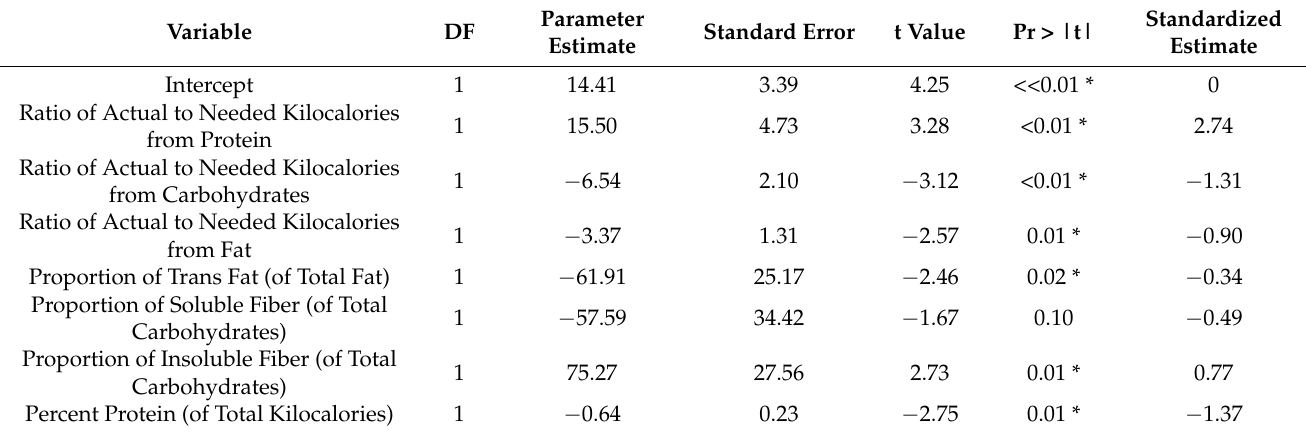
Table 4. Parameter Estimates for Predicting A1c